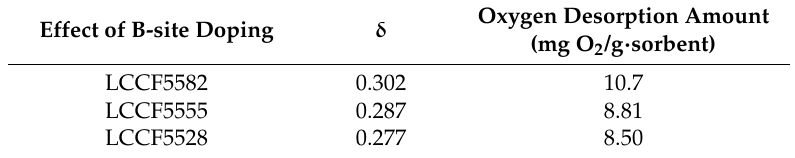
Effect of A-/B-site doping on oxygen non-stoichiometry and performance